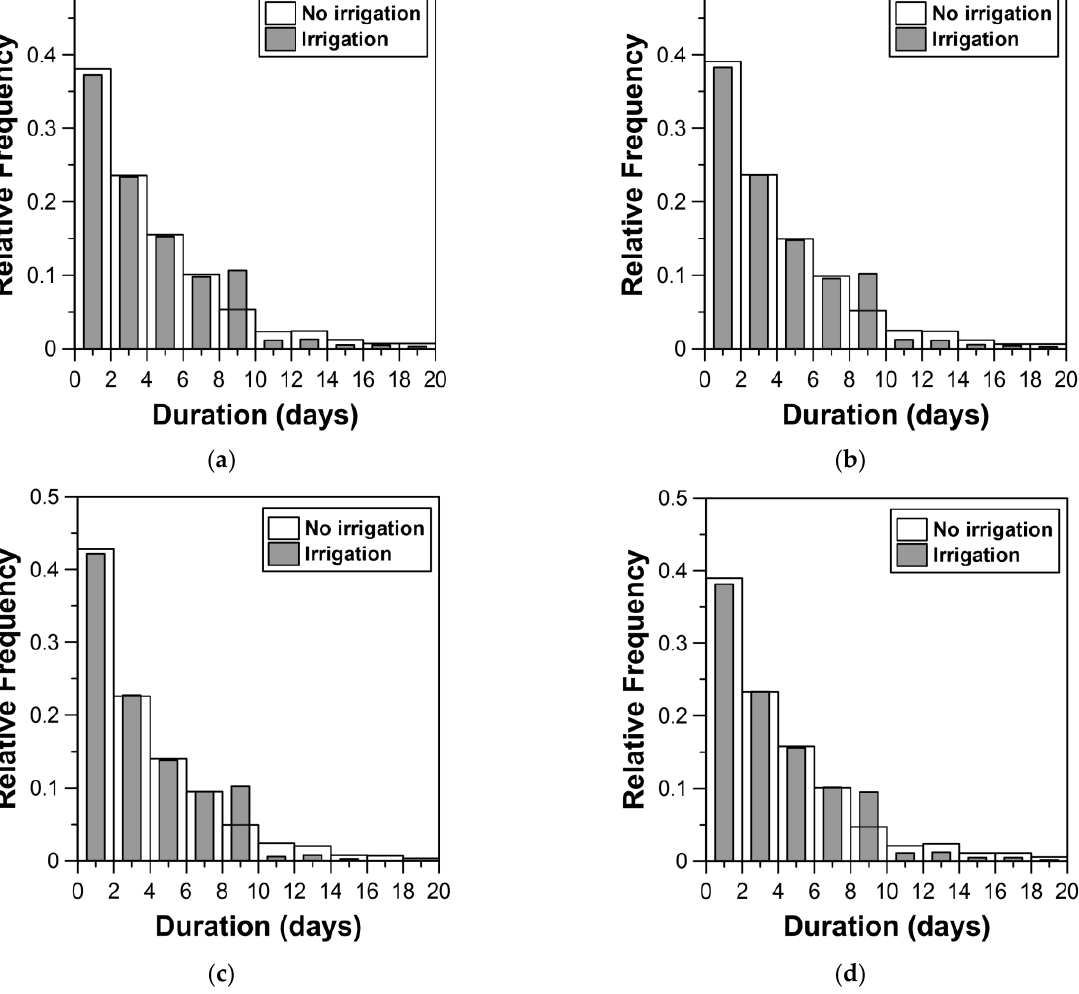
Figure 13. Comparison of irrigation intervals, before (i.e., without irrigation from Mul-Tongs) and after introducing the mool-tongs (i.e., with irrigation from the Mool-Tongs), for each crop considered in this study. ( a ) Garlic; ( b ) Spring Onion; ( c ) Peanut; ( d ) Barley. Table 8. Comparison of exceedance probability (%) of irrigation intervals longer than the maximum non-irrigation days, by crop.